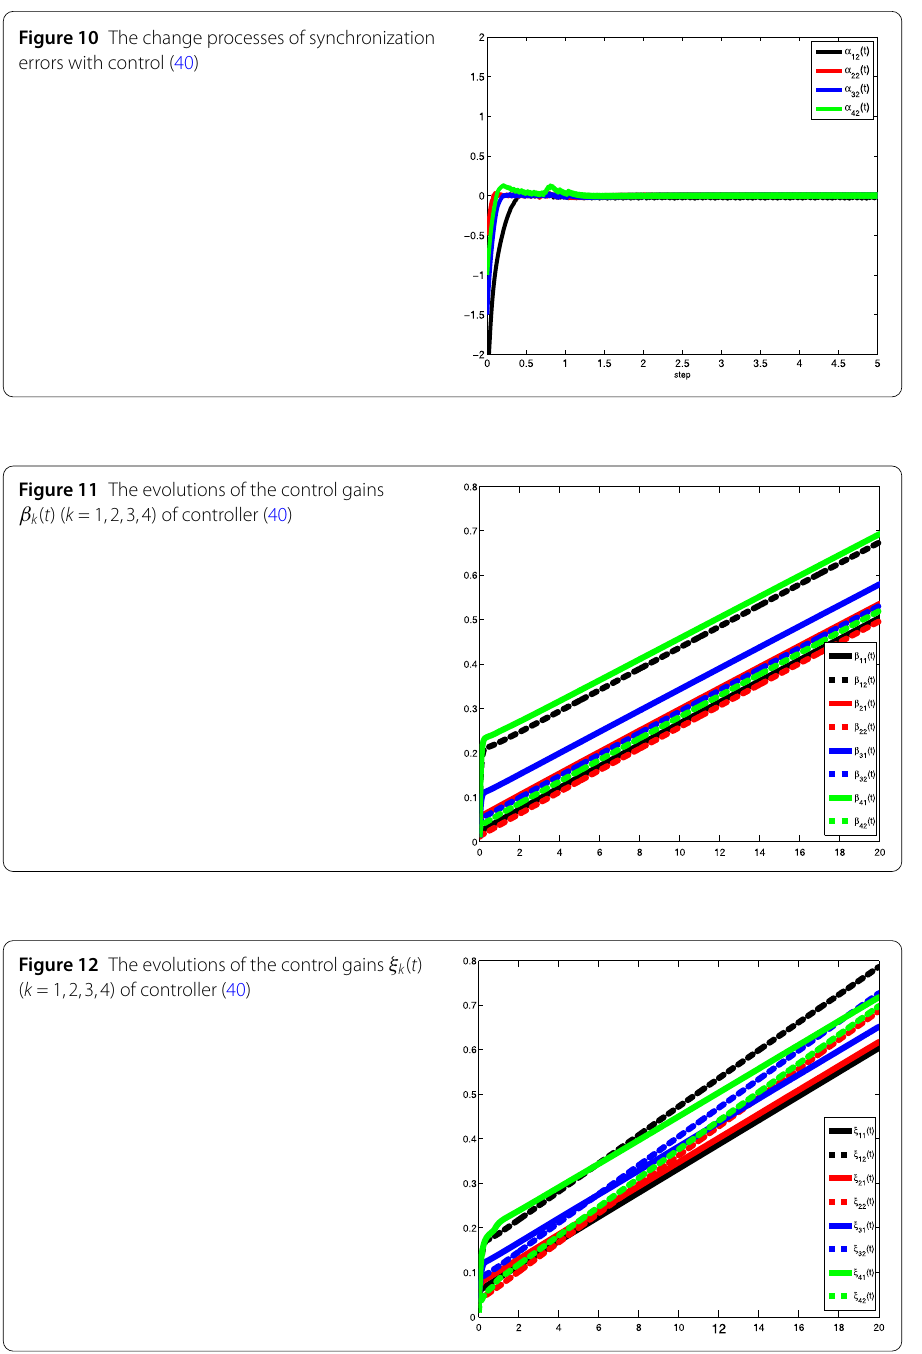
Figure 10 The change processes of synchronization errors with control (40)